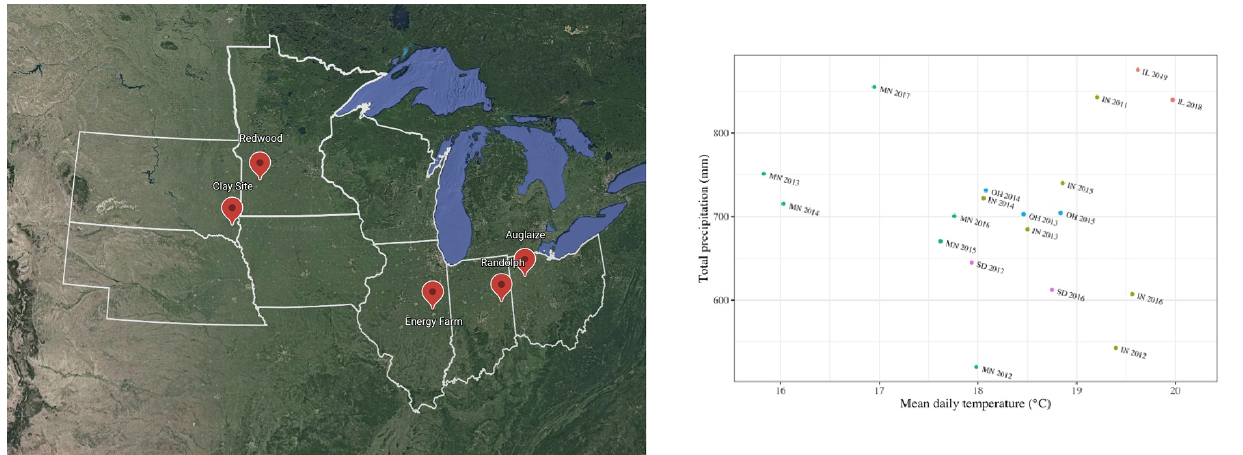
Figure 1. Left: site map (ESRI). Right: scatterplot demonstrating site-year total precipitation and average daily temperature ( ◦ C) for each site year between April and October. Climate information was extracted and averaged across the 10 ERA5 weather ensembles for each site